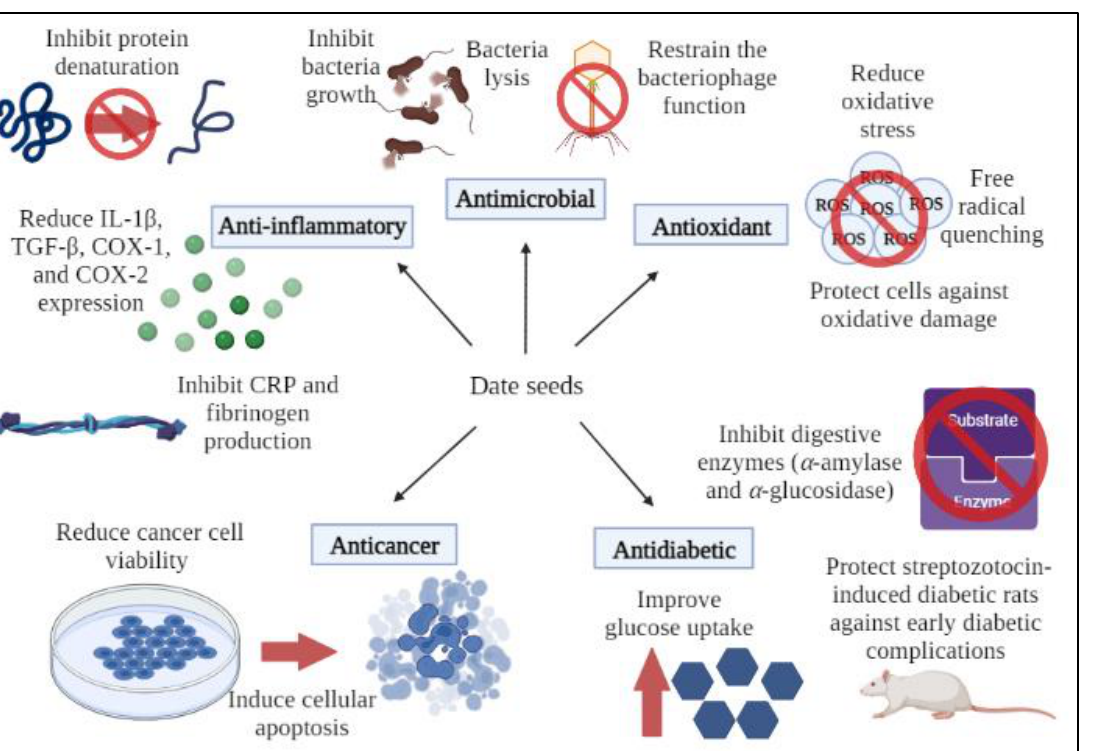
Figure 1. A schematic representation of the biological activities of date seeds. The highly valuable constituents of date seeds contribute to its antimicrobial, antioxidant, anticancer, antidiabetic, and anti-inflammatory properties.